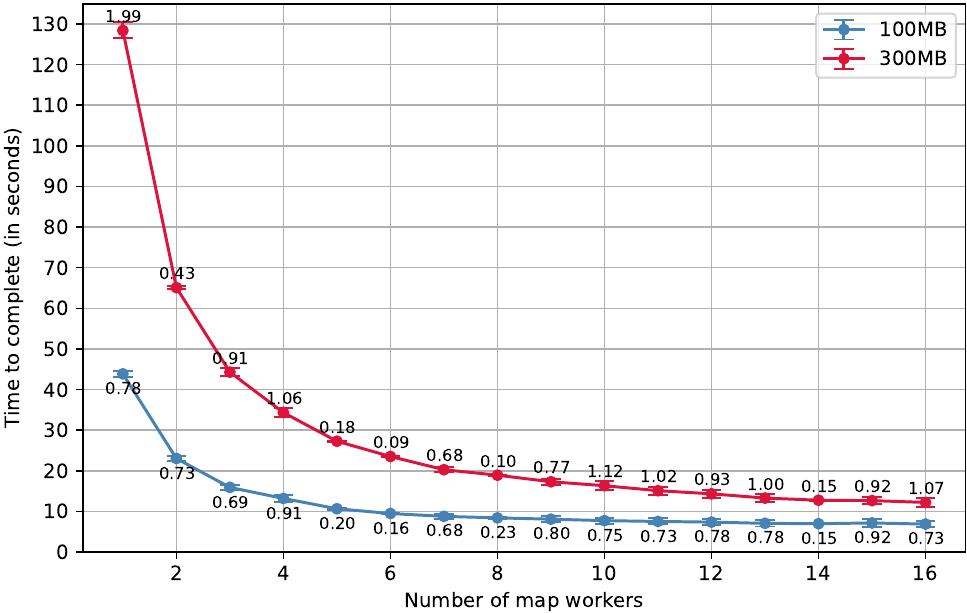
Figure 15. Results obtained from counting the words in datasets with sizes of 100 MB and 300 MB. Standard deviation is shown as an error bar, and the corresponding standard deviation value is displayed above each data